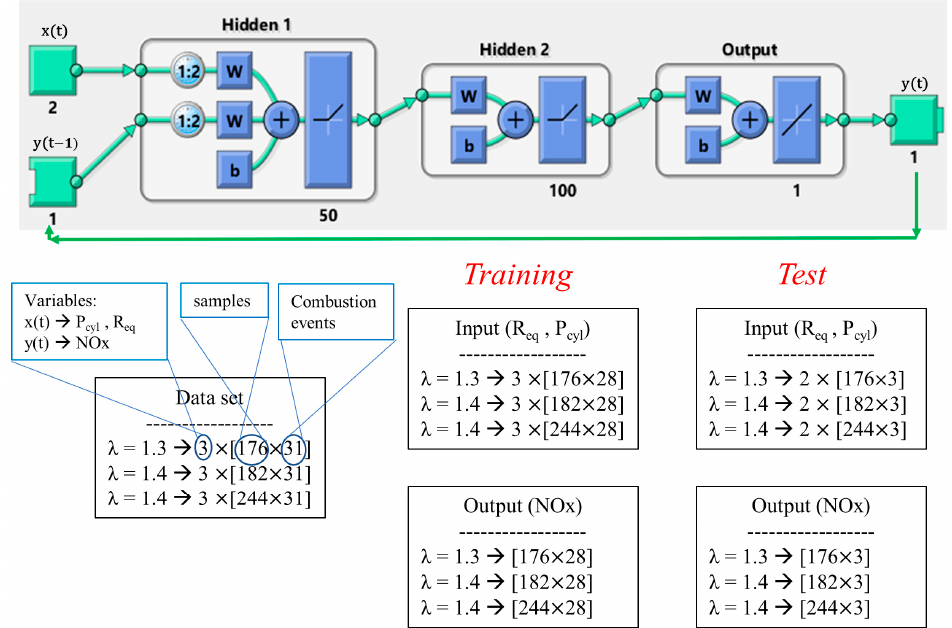
Figure 9. Neural network structure for the NOx prediction. Characteristics of training and test session.